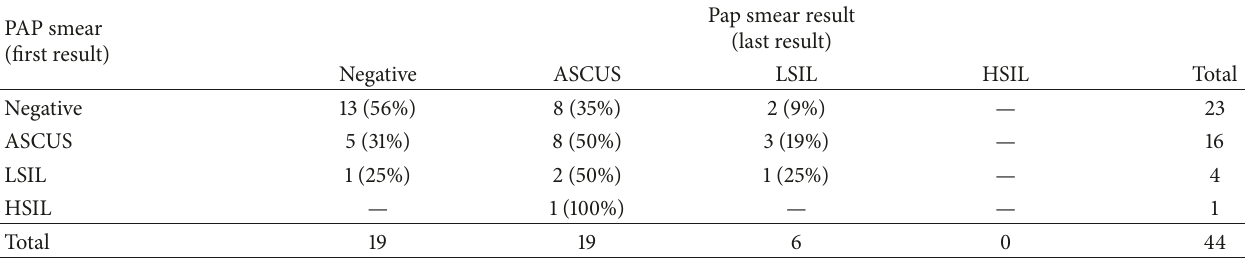
Table 4: Pap smear progression: first Pap smear to last Pap smear, for HIV+ women > 65, with 3 or more Pap smear results ( 𝑛 = 44 ). PAP smear